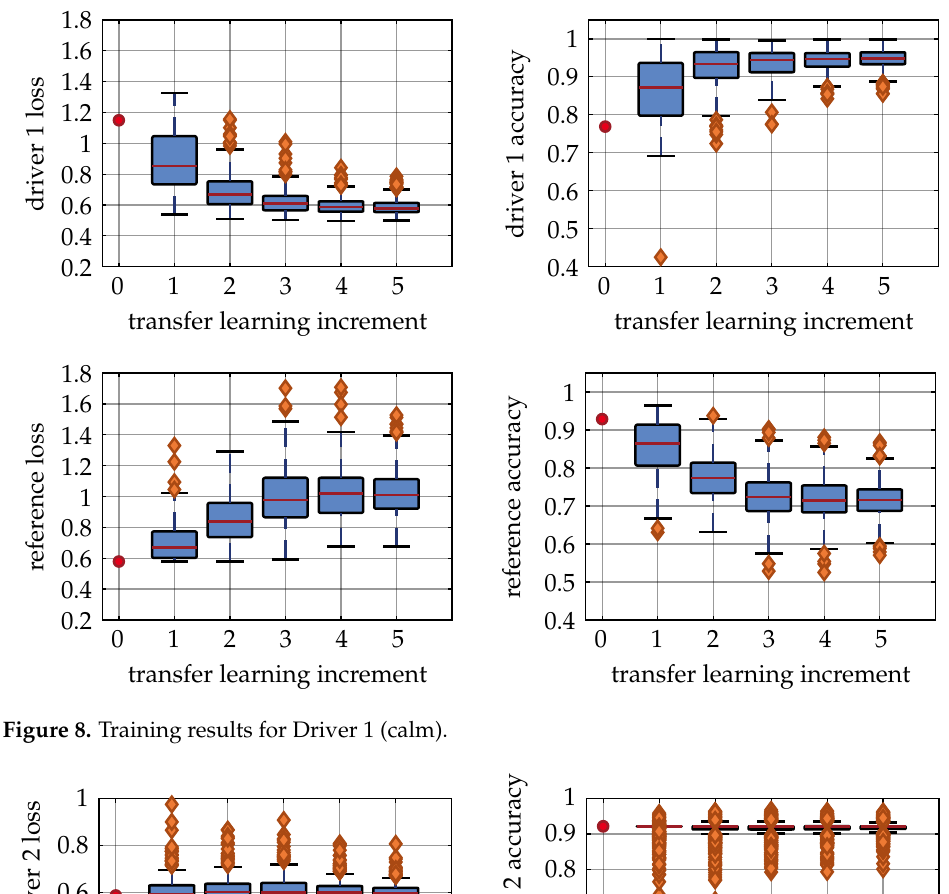
Table 5: Main parameters in the learning process. # of training samples/increment